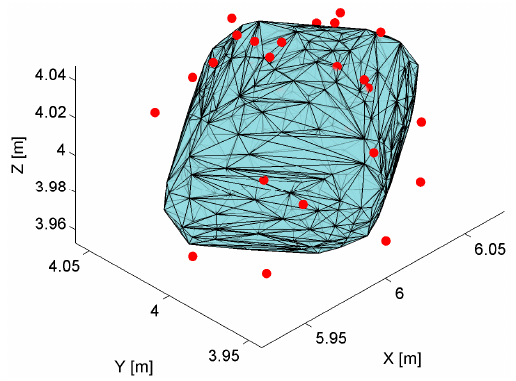
Figure 17. The example of theoretical solid with a number of experimental location estimates outside the solid (red dots).